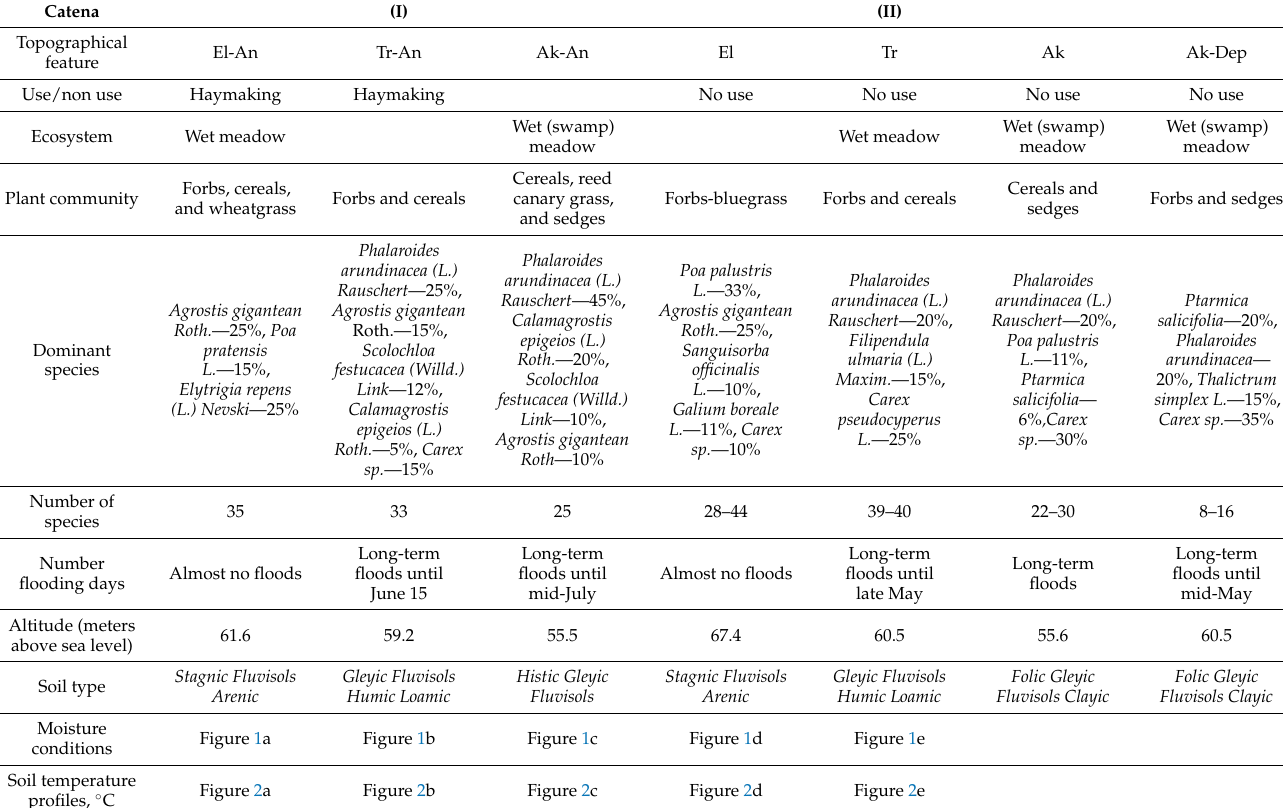
Table 1. Description of natural ecosystems at two catenas in the floodplain of the Ob